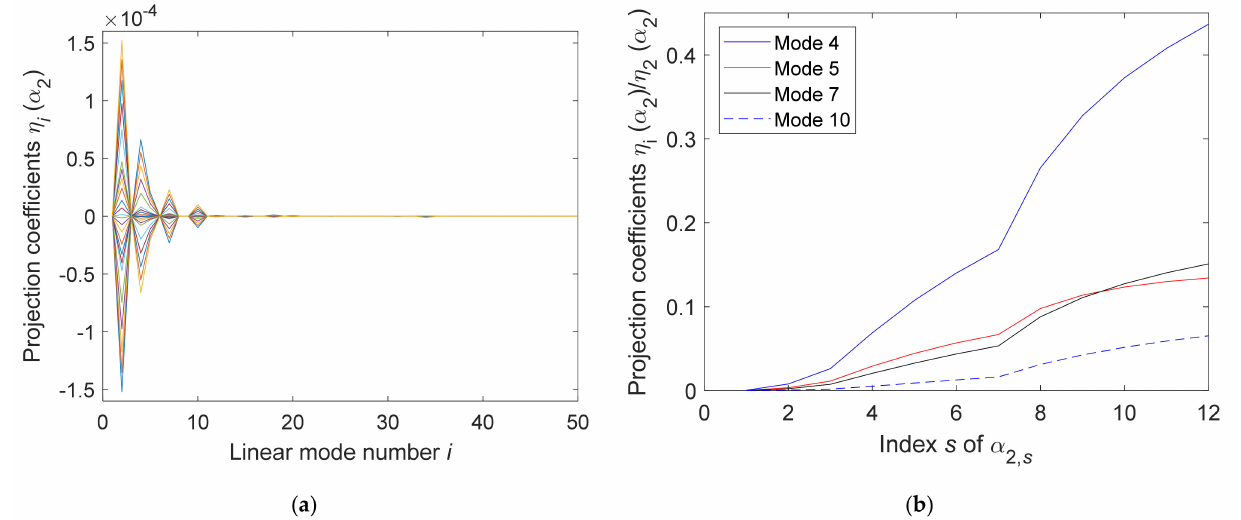
Figure 21. Projection coefficients η i ( α 2 ) of the static responses w 2 ( α 2 ) . Beam on spring supports from Figure 19. ( a ) η i ( α 2 ) vs. linear mode i for all load levels α 2, s . ( b ) Normalized coefficients ( α ) / η ( α ) | vs. load level α | η 2 2 2, s for selected modes i = 4, 5, 7, and i 2